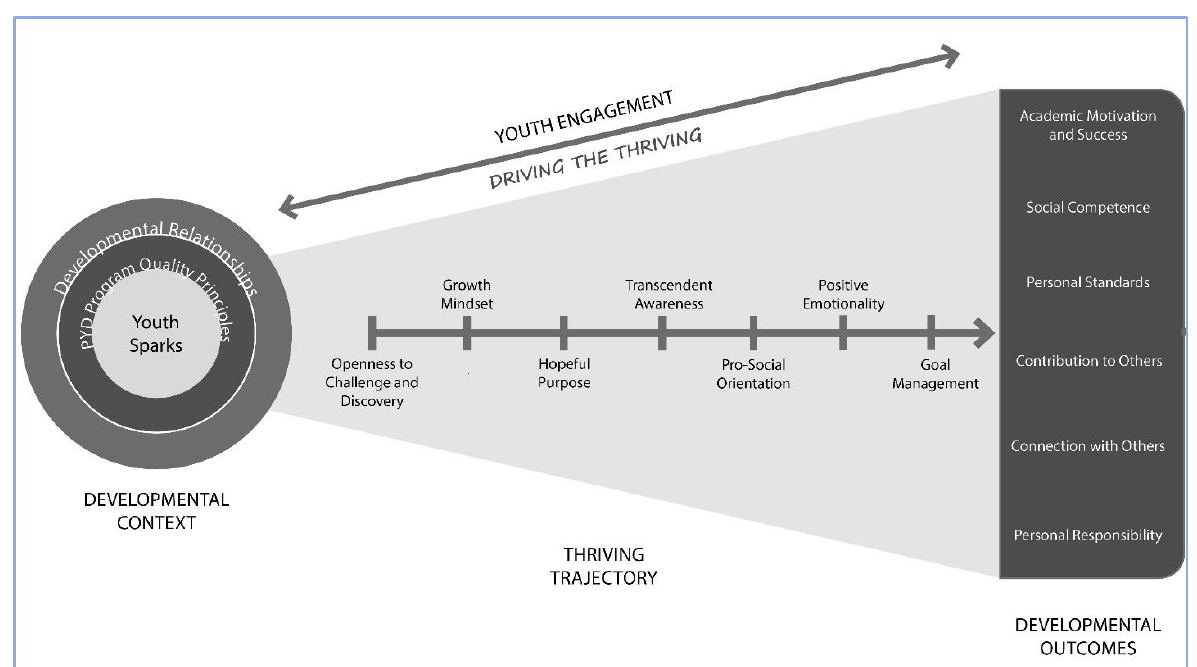
Figure 2. Revised 4-H Thriving